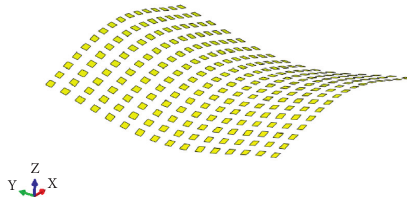
Figure 17: Saddle deformation.